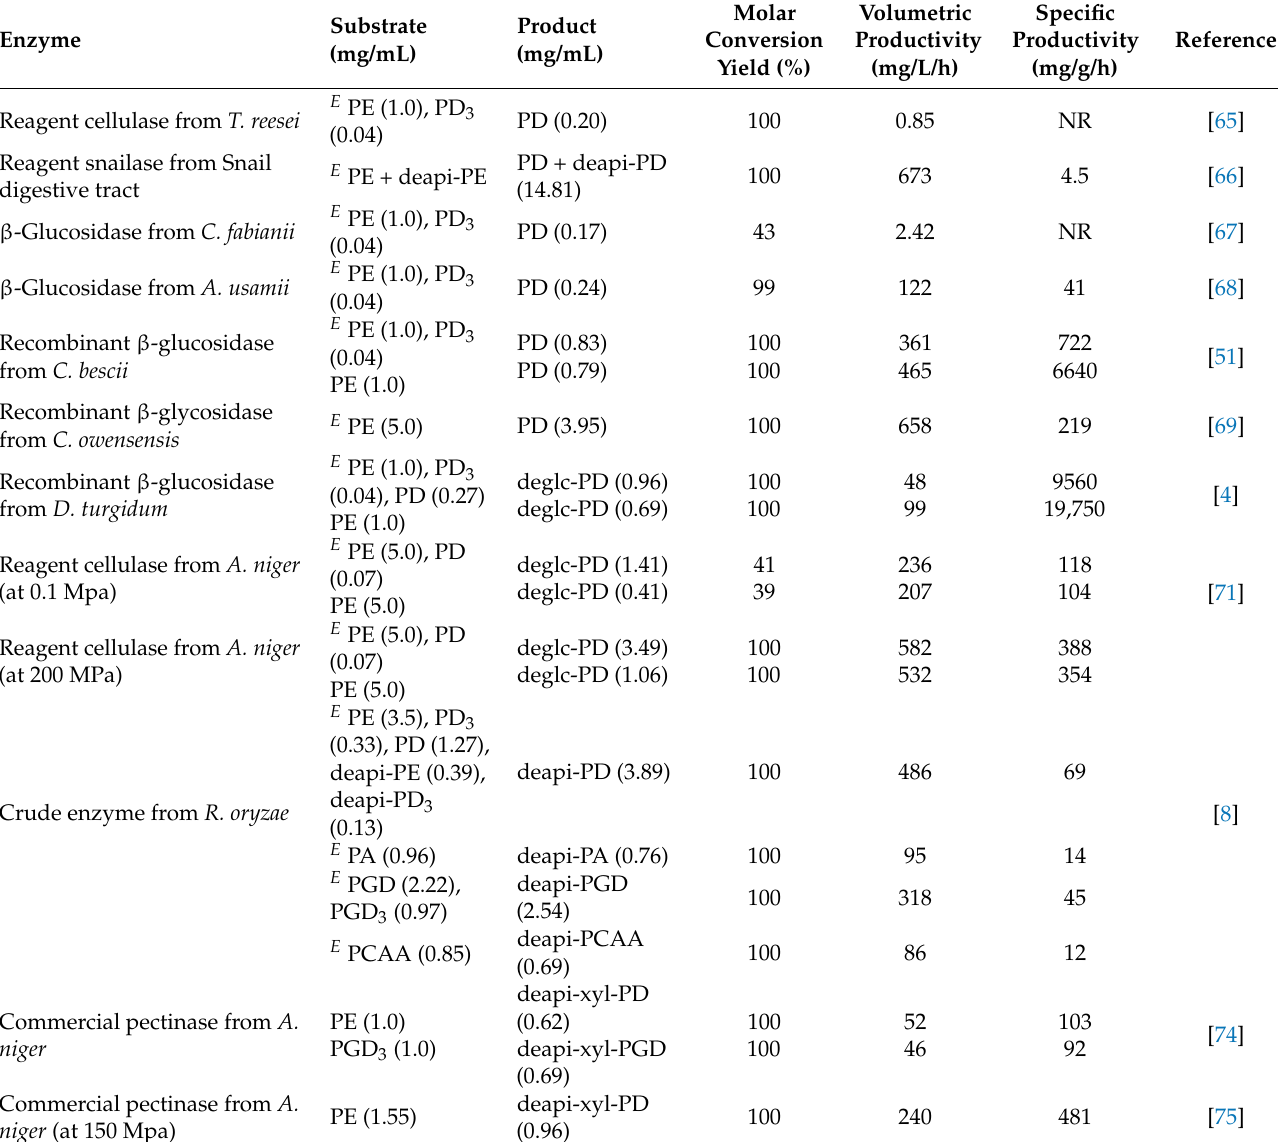
Table 3. Quantitative biotransformation of glycosylated platycosides into deglycosylated platycosides by